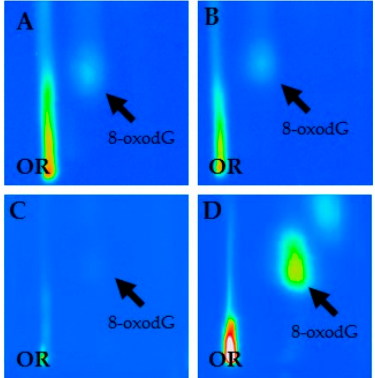
Figure 1. Characteristic chromatographic patterns of 8-hydroxy-2 ′ -deoxyguanosine (8-oxodG) in current ( A ) and former ( B ) exposed asbestos workers, unexposed healthy controls ( C ) and positive standard ( D ).